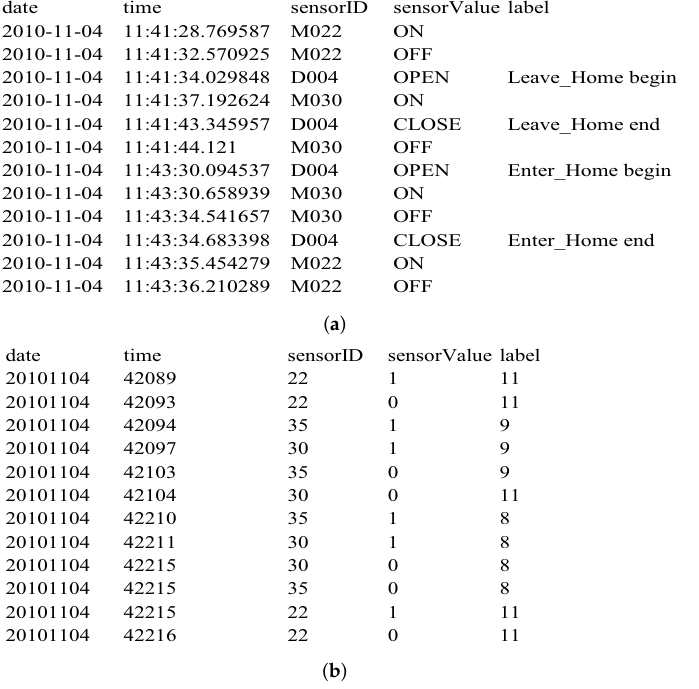
Figure 5. A sample dataset of Aruba. ( a ) Raw data sample. ( b ) Digitized data sample. Table 1. Number of sensor events of